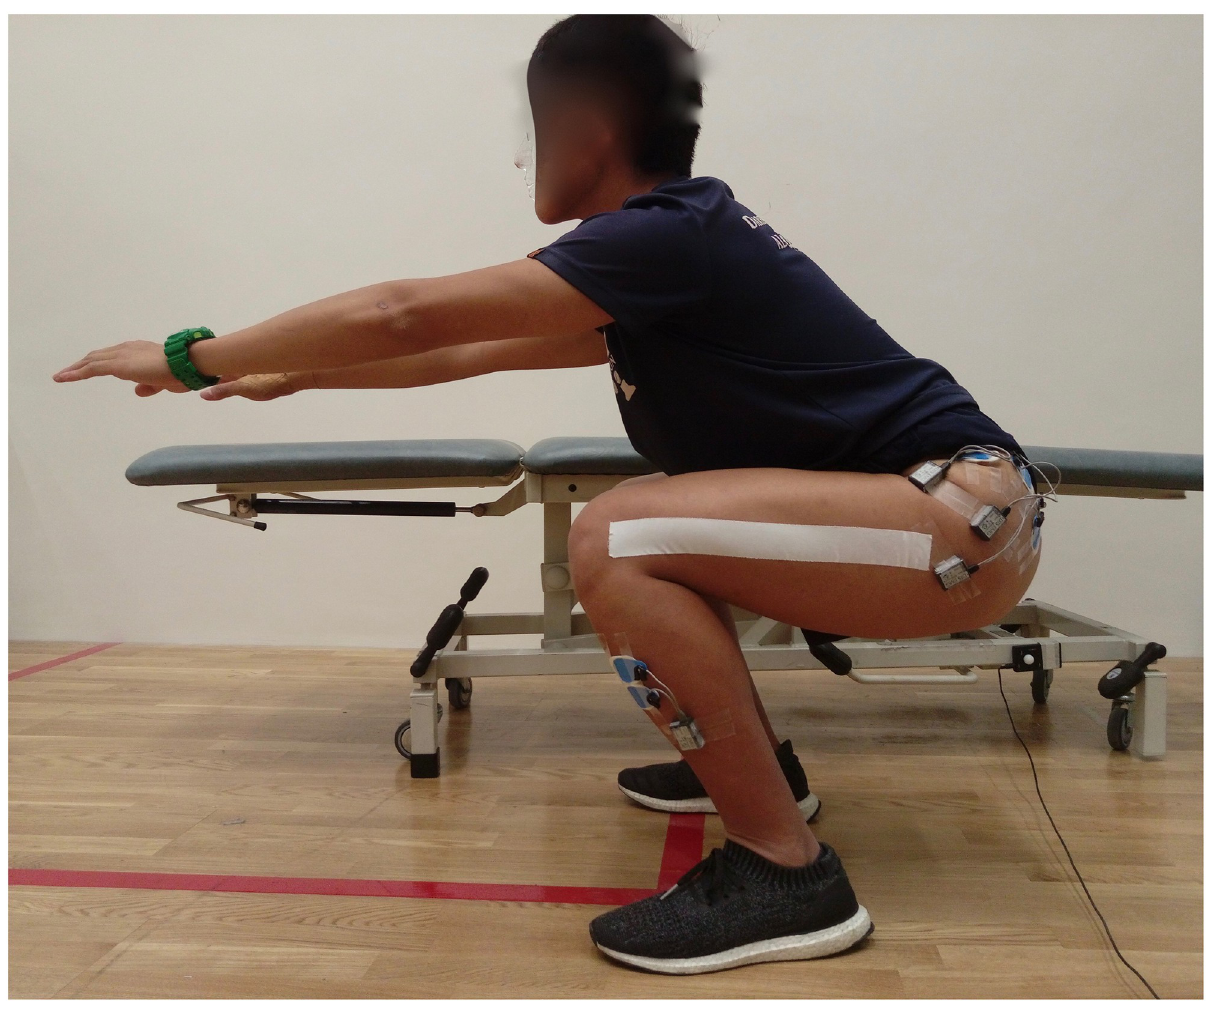
Fig 5. Squat with electromyography